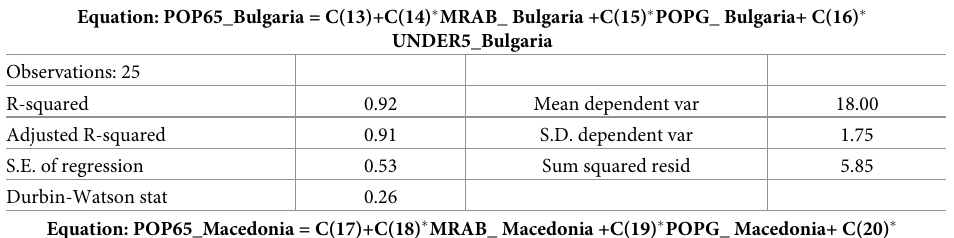
Table 4. System estimation by country